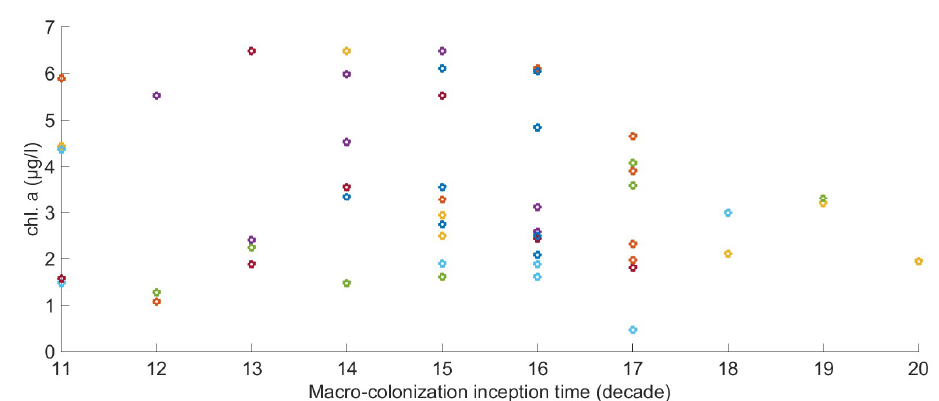
Figure A3. The relationship between macro-colonization starting times (end of the initiation phase) expressed in 10 days; each color represents a year of the 1996–2012 time-series.